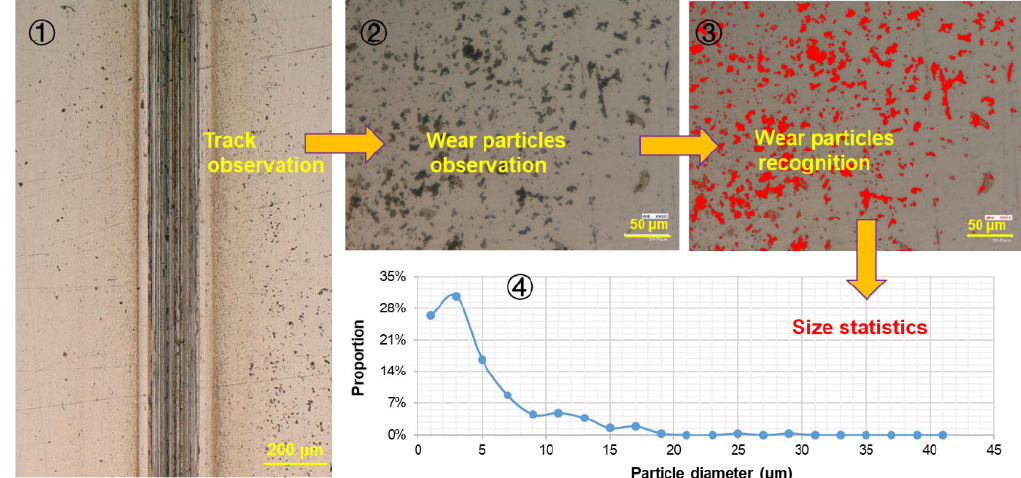
Fig. 12 Processes of wear particle size observation in the lubricant and its statistics analysis